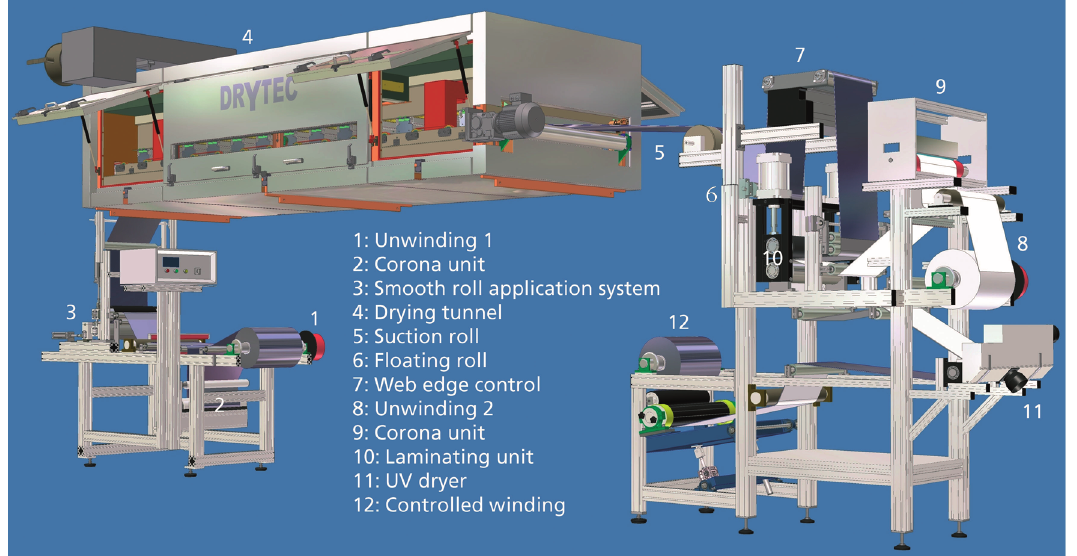
Figure 2. Schematic diagram of the lacquering and laminating plant (figure source: Fraunhofer